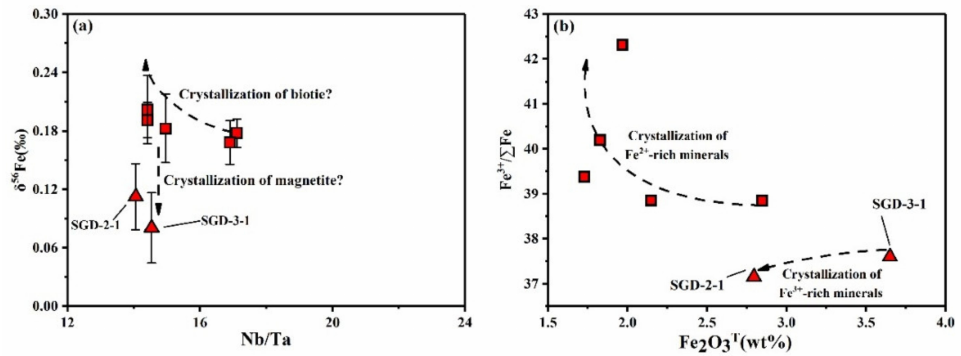
Figure 11. ( a ) Nb/Ta vs. δ 56 Fe, ( b ) Fe 2 O 3T vs. δ 56